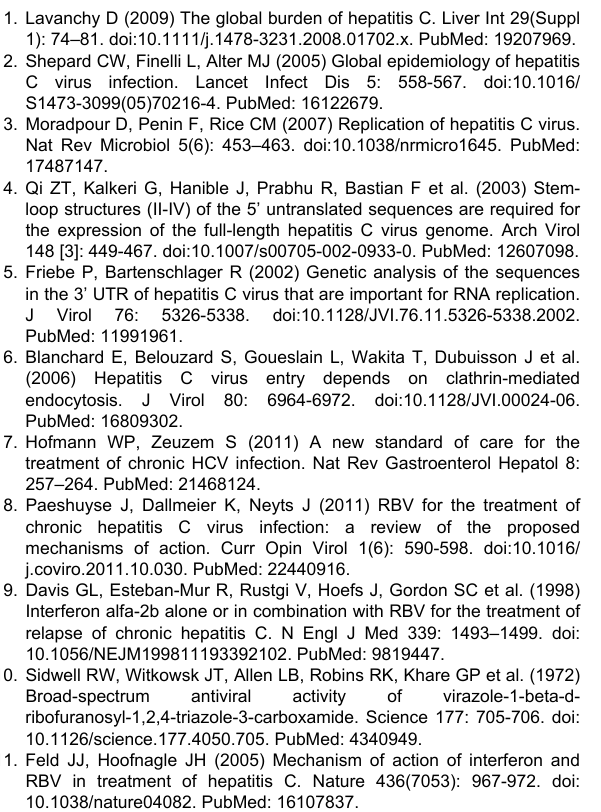
Figure S1. HCV genomic and sub-genomic constructs and cell culture models used to study IFN-α and RBV antiviral synergy mechanisms.